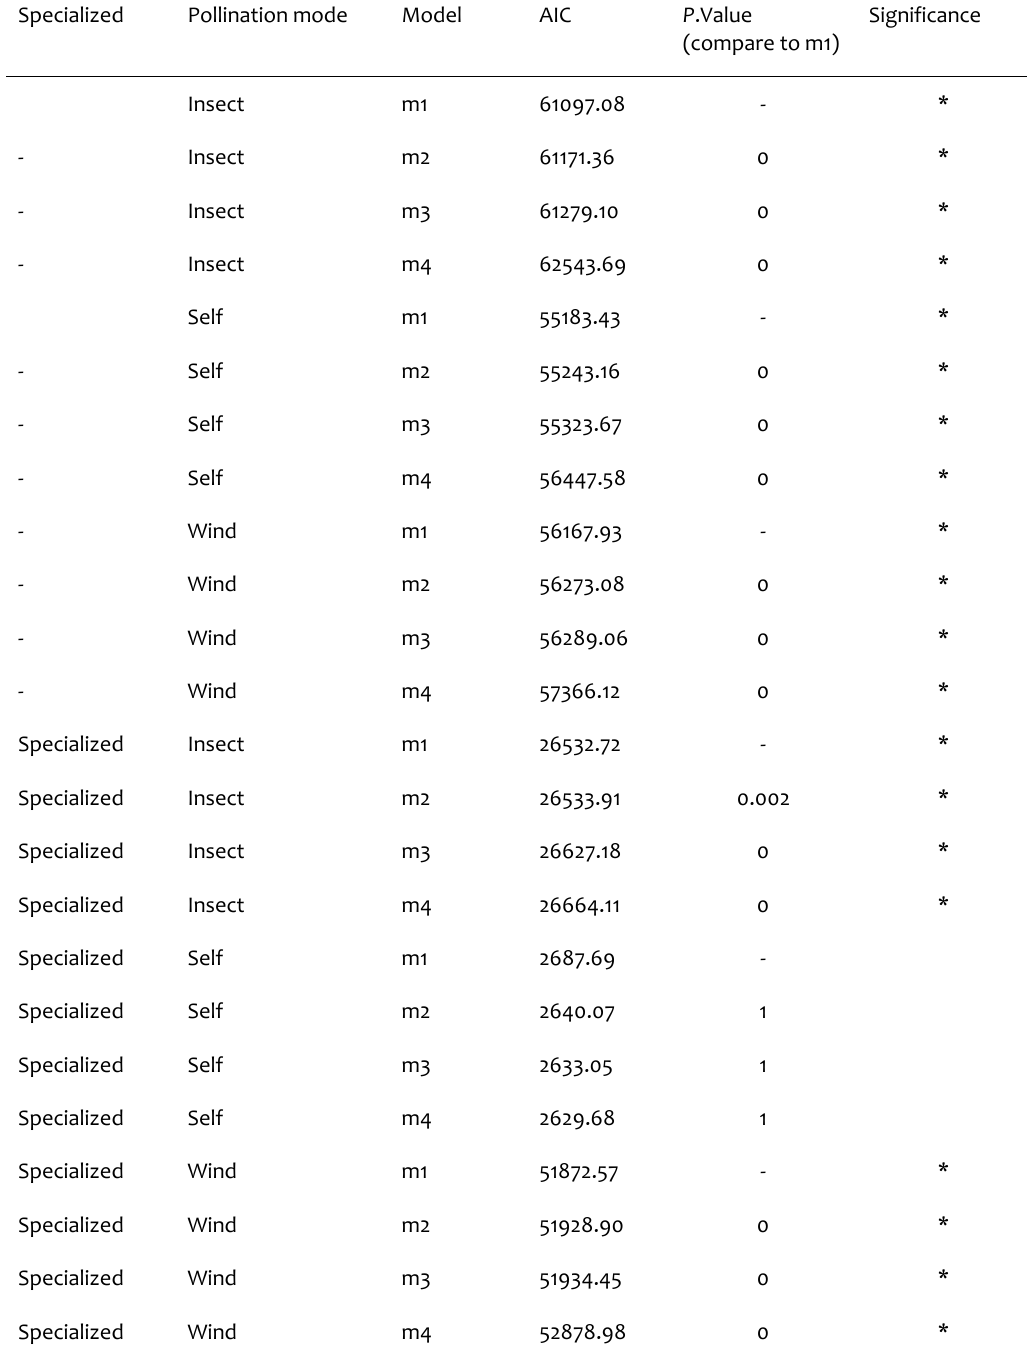
Table 2. Comparisons between each individual model (m2-m4) and the full model (m1). m1: richness ~ canopy densities of 0.5- 2 m vegetation * habitat type + canopy densities of 2-5 m vegetation * habitat type + canopy densities of 5-10 m vegetation * habitat type + canopy densities of 10-20 m vegetation * habitat type. m2: richness ~ canopy densities of 0.5-2 m vegetation + canopy densities of 2-5 m vegetation + canopy densities of 5-10 m vegetation + canopy densities of 10-20 m vegetation + habitat type. m3: richness ~ habitat type. m4: richness ~ canopy densities of 0.5-2 m vegetation + canopy densities of 2-5 m vegetation + canopy densities of 5-10 m vegetation + canopy densities of 10-20 m